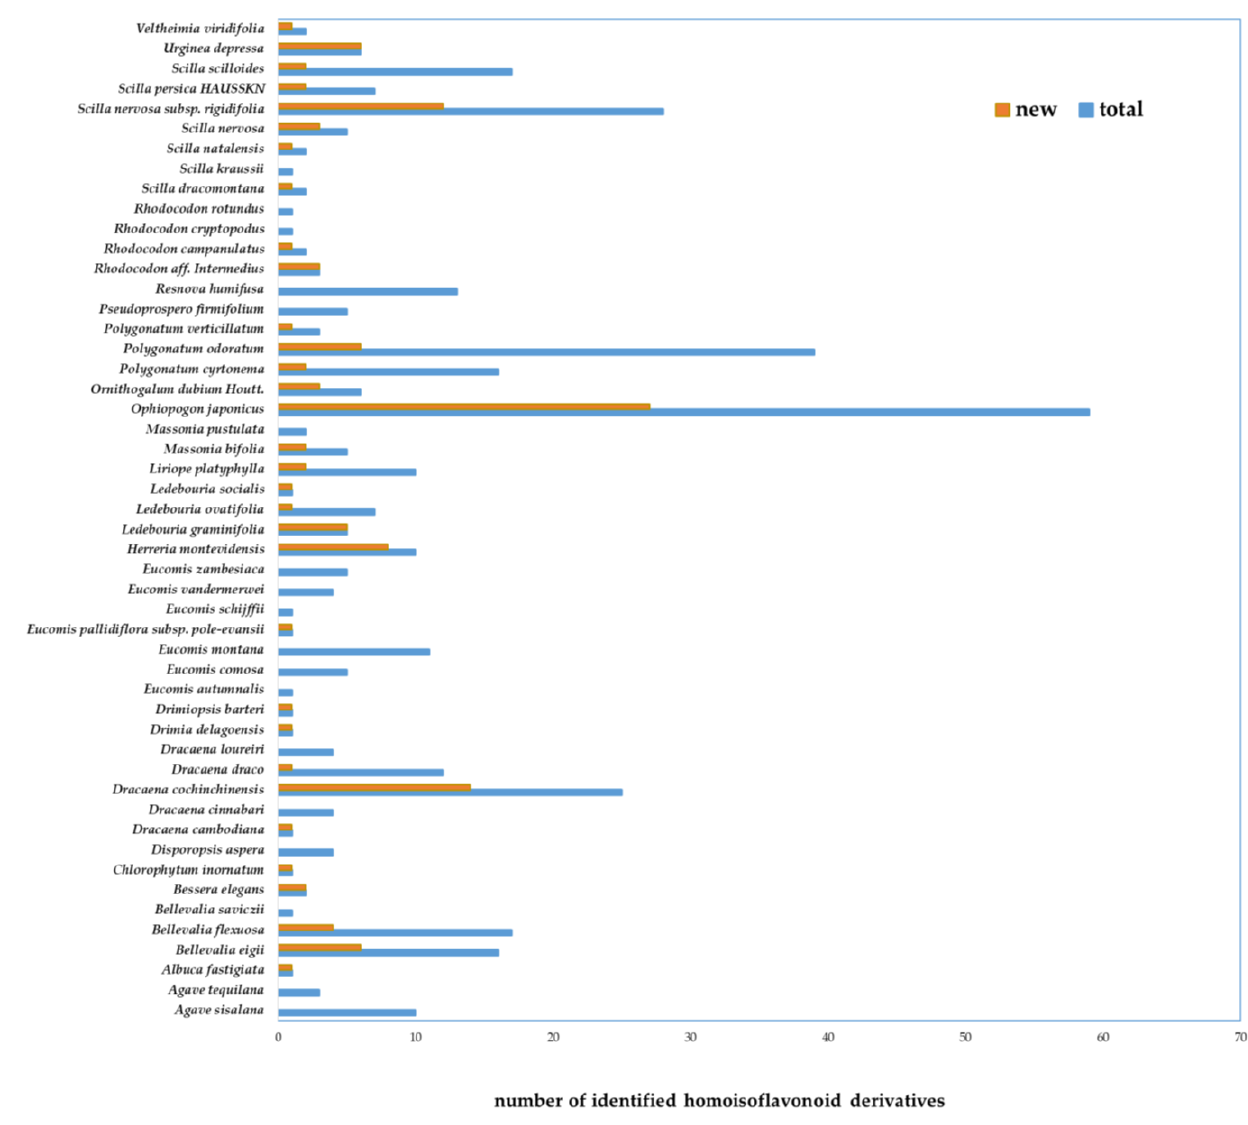
Figure 2. Abundance comparison of the novel homoisoflavonoids (identified for the first time) with total derivatives isolated from species of Asparagaceae family.